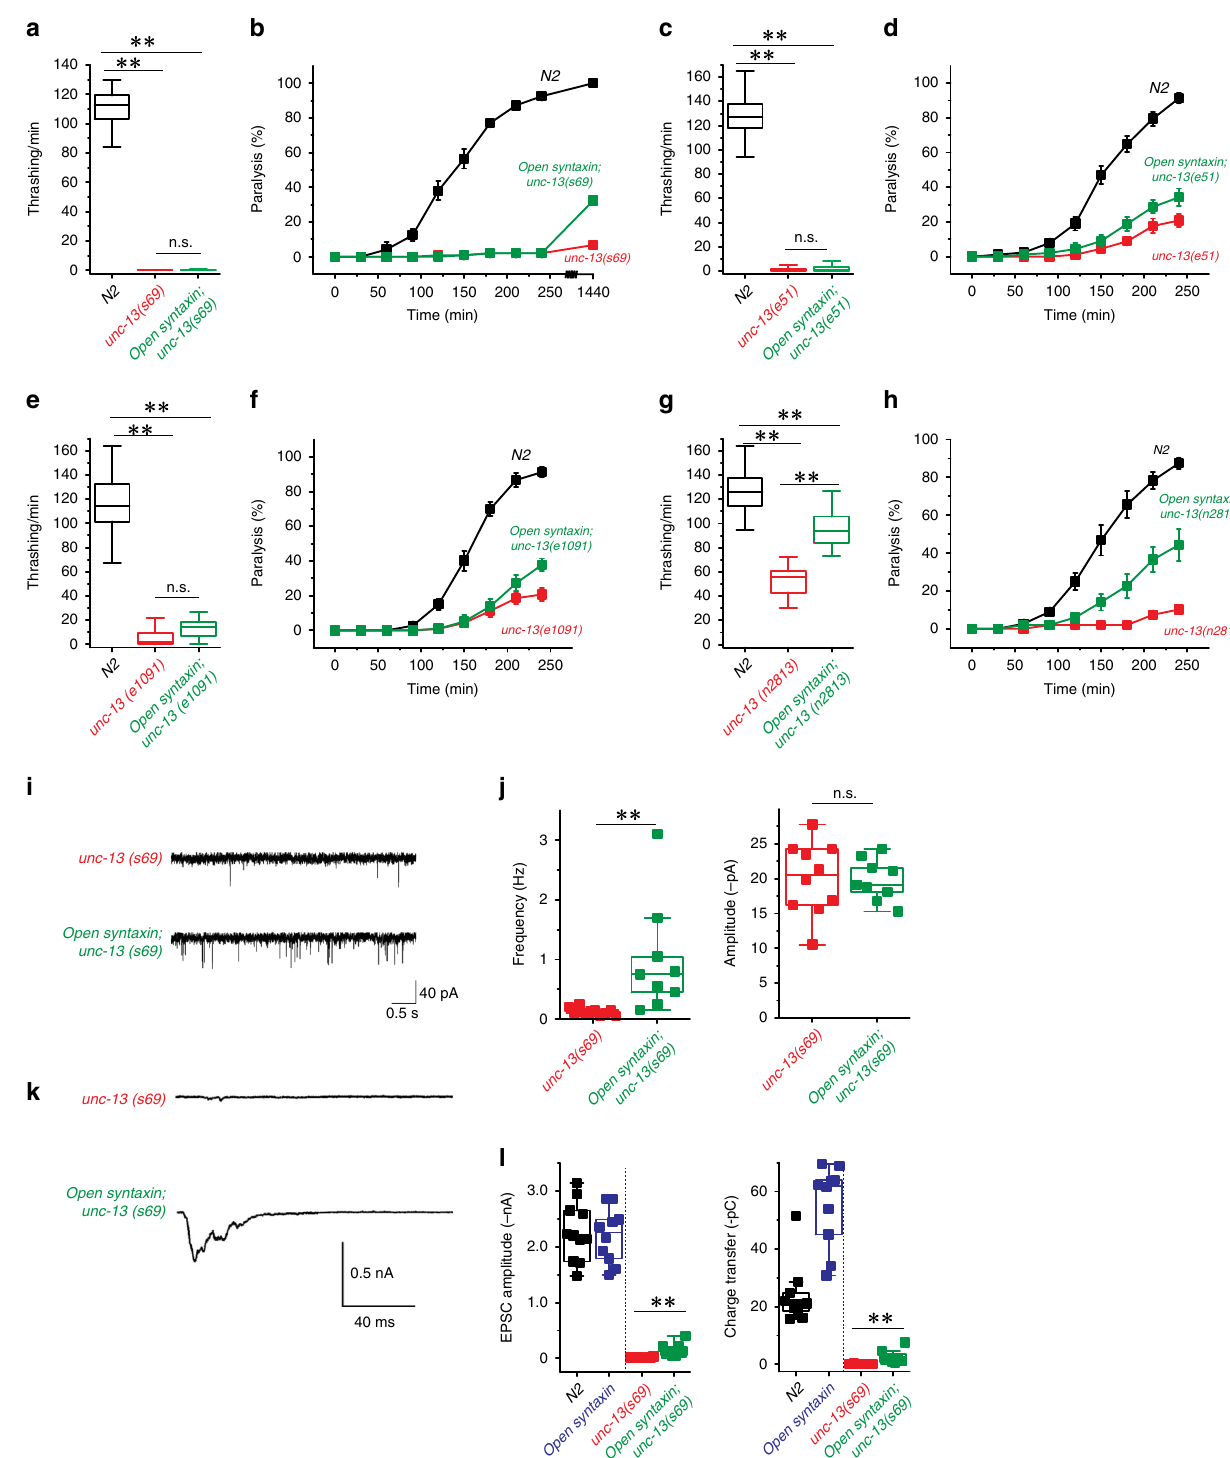
e1091 , and n2813 . e51 and e1091 mutants are null in their LR isoform only, while n2813 mutants possess a partial loss-of- function gene that results in a single S1574R missense mutation in both UNC-13 isoforms 12 . Open syntaxin KI ; unc-13(e51) double mutants did not show rescued thrashing ( p = 0.91) but did display increased sensitivity to aldicarb compared to the unc- 13(e51) mutant alone (Fig. 5c, d). Similarly, open syntaxin KI ; unc-13(e1091) double mutants did not show rescued